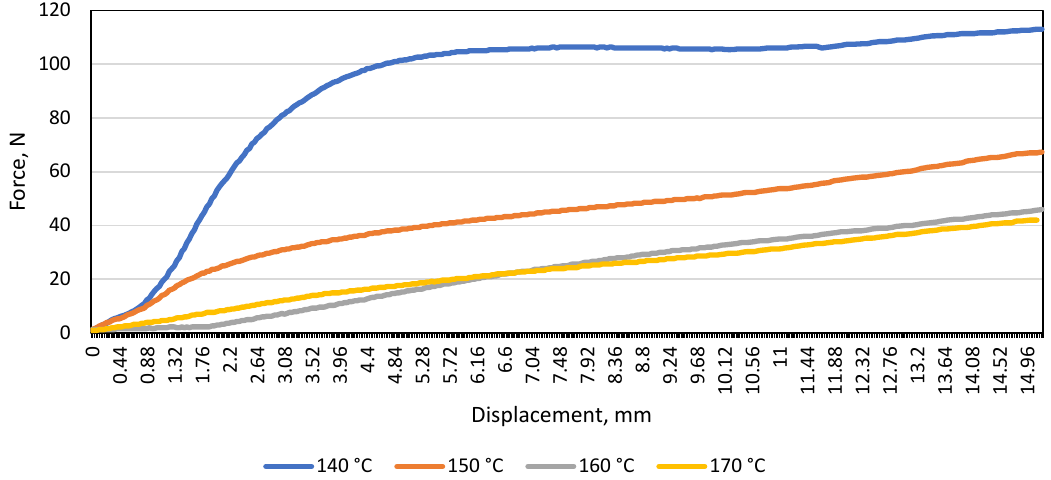
Figure 6. Diagram of the load and displacement of the patterned material B during bending at different temperatures when the distance between the supports was 100 mm.